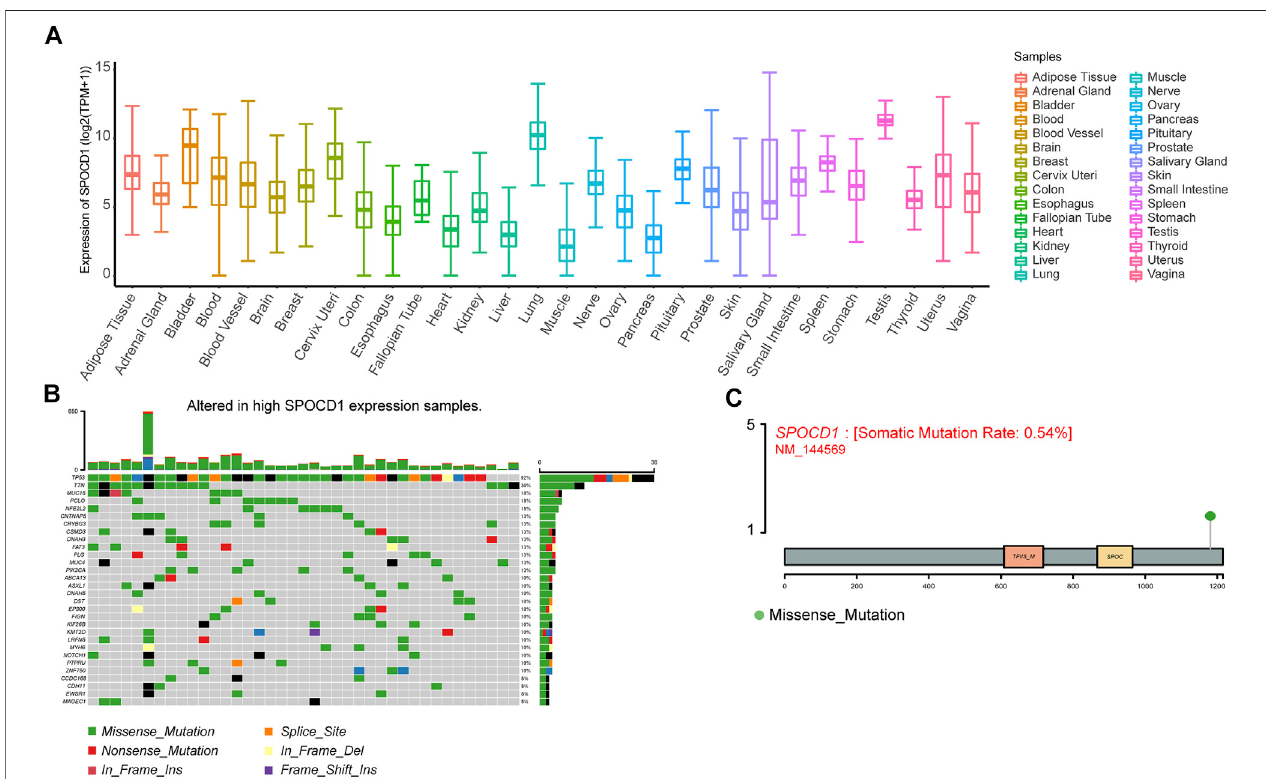
FIGURE 4 | Correlation analysis of SPOCD1 expression and mutation. (A) The expression of SPOCD1 in human tissues; (B) Mutant panorama of high SPOCD1 expression group; (C) Map of SPOCD1 mutation site information. SPOCD1, SPOC Domain Containing 1; CNV, copy number variation.